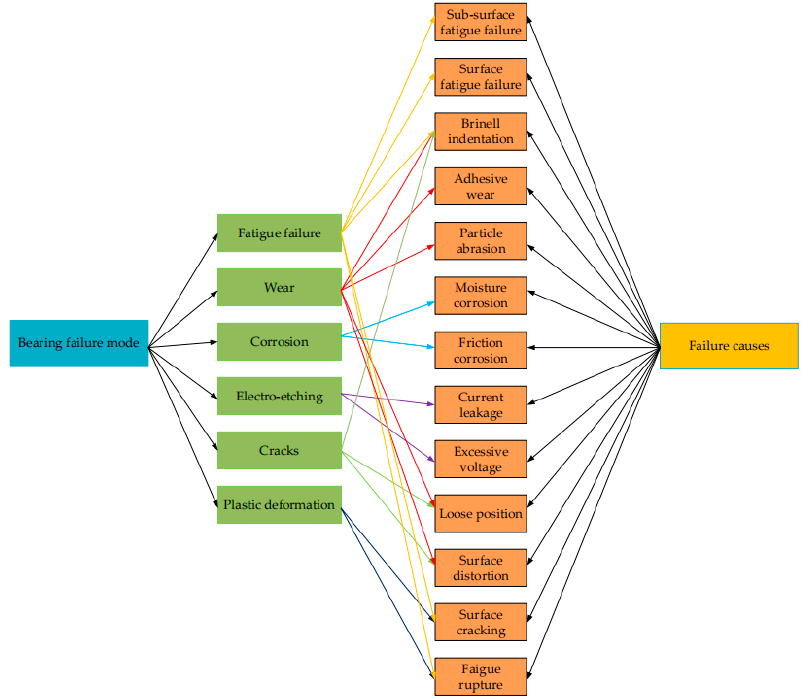
Figure 5. Classification of bearing friction failure modes in wind turbines (Adapted from [69,70]). Table 3. Frictional failure analysis of wind turbine bearings (Adapted from [67,71,72]). Failure Type